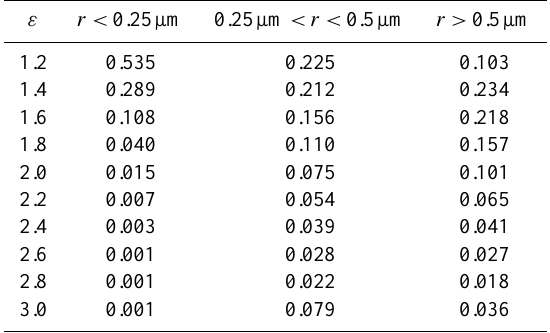
Table 2. Aspect ratio distributions as function of particle radius in- terval discretized from measurement data of Kandler et al. (2009). The first line covers the measurement data from ε = 1 . 0 to 1.3, the last line covers ε > 2.9 and the other values cover ε -intervals of 0.2.